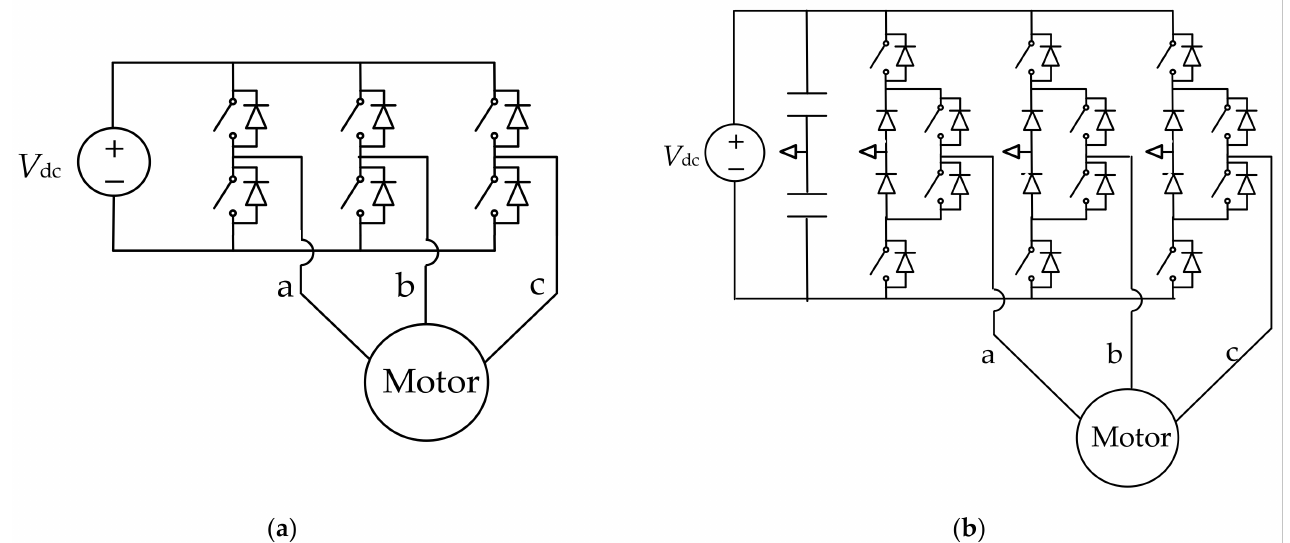
Figure 1. Three-phase motor drives. ( a ) Conventional two-level converter; ( b ) three-level diode- clamped NPC